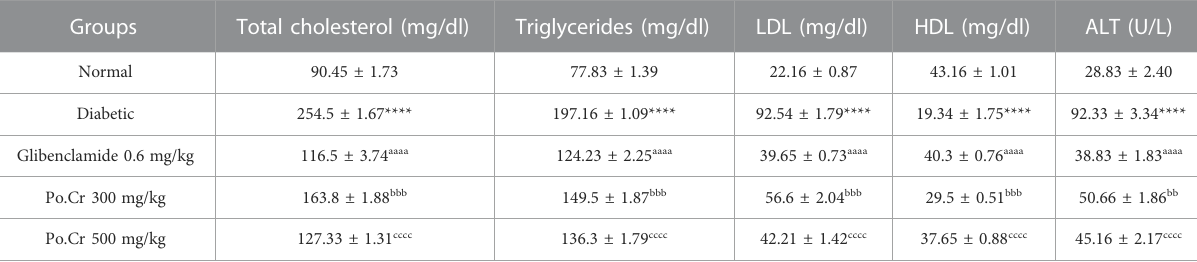
TABLE 2 The levels of TC, TG, LDL, HDL, and ALT in blood serum ( n = 8). Group II (diabetic control) was compared to Group I (normal control), whereas all the treated groups (Groups III [standard treatment] to V [Po.Cr]) were compared with Group II (diabetic control). ANOVA (two-way) and the multiple comparison Dunnett ’ s test were applied, and the data values are mean ± SEM. * p < 0.05 and a p < 0.05 indicate comparison of the diabetic control (Group II) to the normal control (Group I) and glibenclamide (Group III), respectively. Whereas b p < 0.05 and c p < 0.05 indicate comparison of Po.Cr, 300 mg/kg (Group IV); and Po.Cr, 500 mg/kg (Group V) versus the diabetic control group,